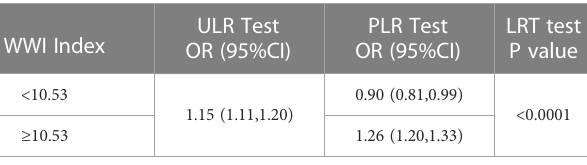
TABLE 4 Two-piecewise linear regression and logarithmic likelihood ratio test explained the threshold effect analysis of WWI index with asthma